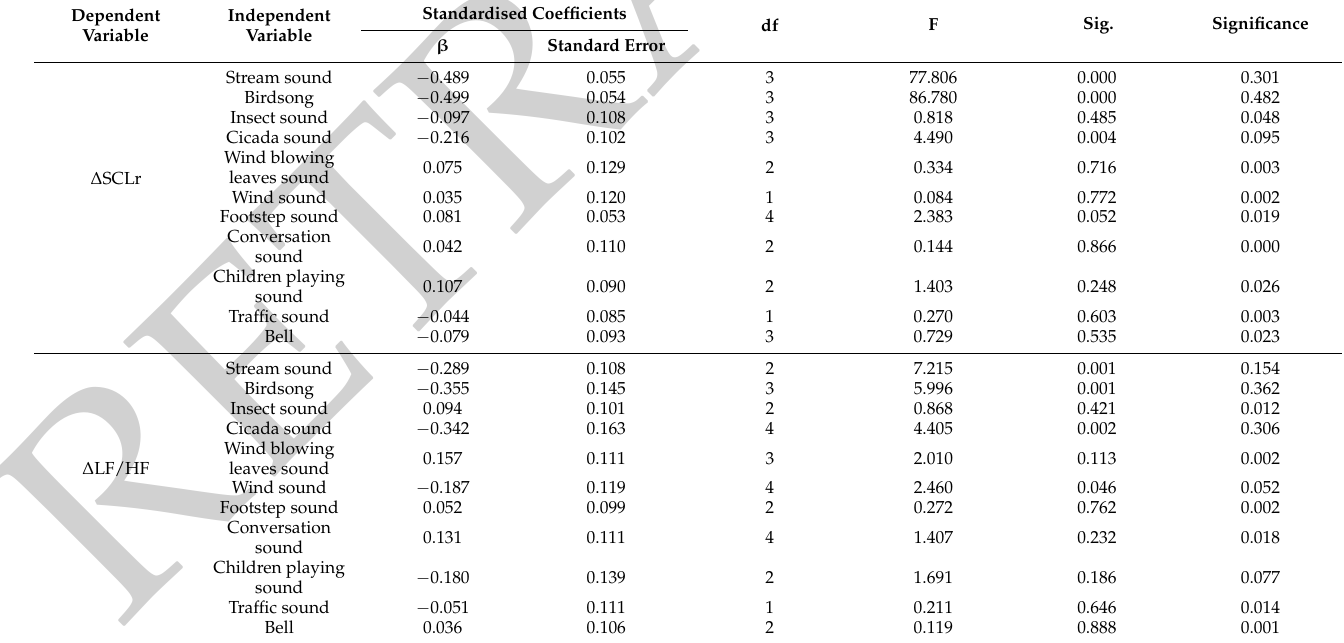
Table 5. Regression analysis of soundscapes and the relieving stress